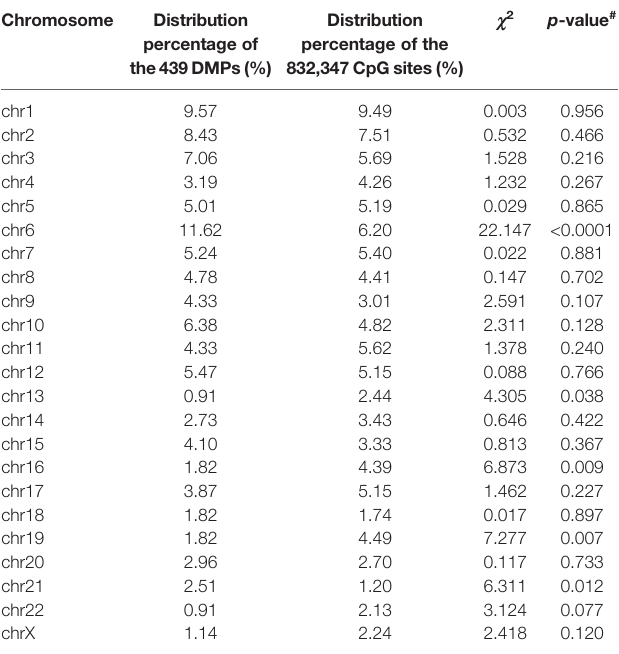
TABLE 2 | Comparisons of the distribution percentages of the 439 DMPs and the 832,347 CpG sites on each chromosome. Chromosome Distribution percentage